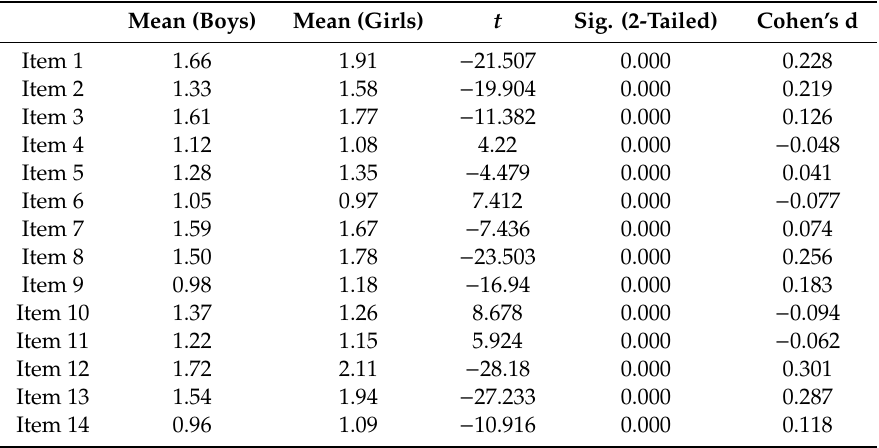
Table 4. t -tests for comparing the means of the teenage boys and teenage